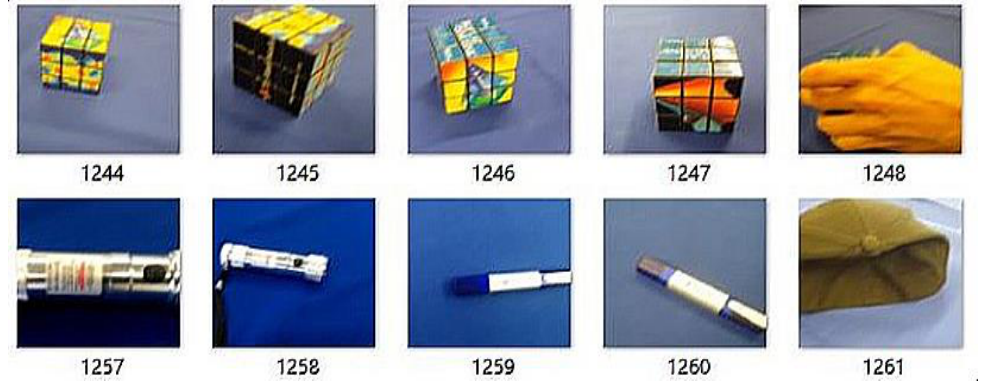
Figure 3. Preview of IAS-Lab RGB face dataset.